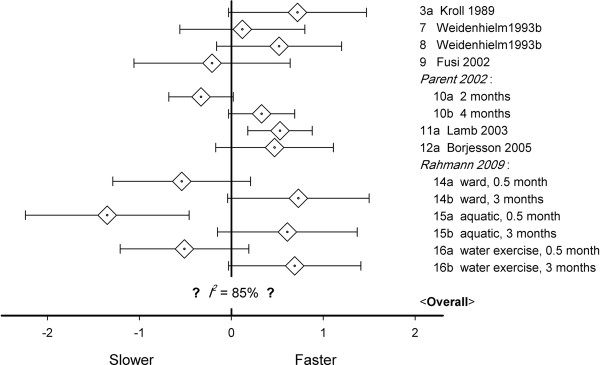
Walking speed effect-sizes in the first 0.5–5 months after knee arthroplasty with mean values (◊) and 95% confidence intervals (horizontal error bars); given the large between-study variance, no valid overall estimate was possible; note that Weidenheim [39] followed two different groups.